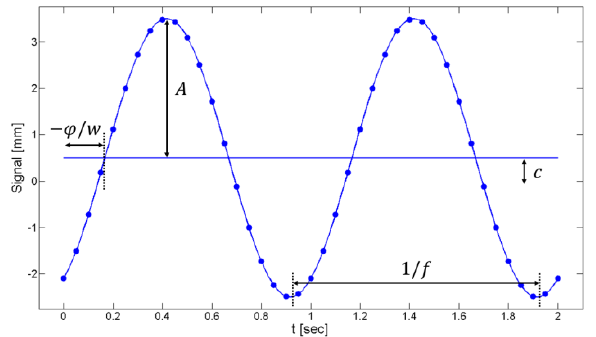
Figure 1. Example of a 1 Hz signal sampled at 20 Hz